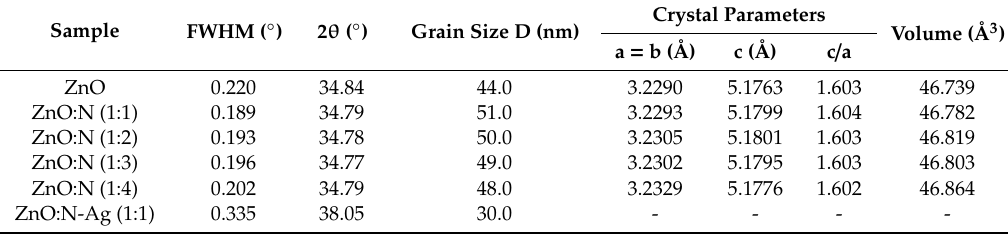
Table 2. Calculated lattice parameter for pure ZnO, ZnO:N, and ZnO:N-Ag (1:1) NRs films.